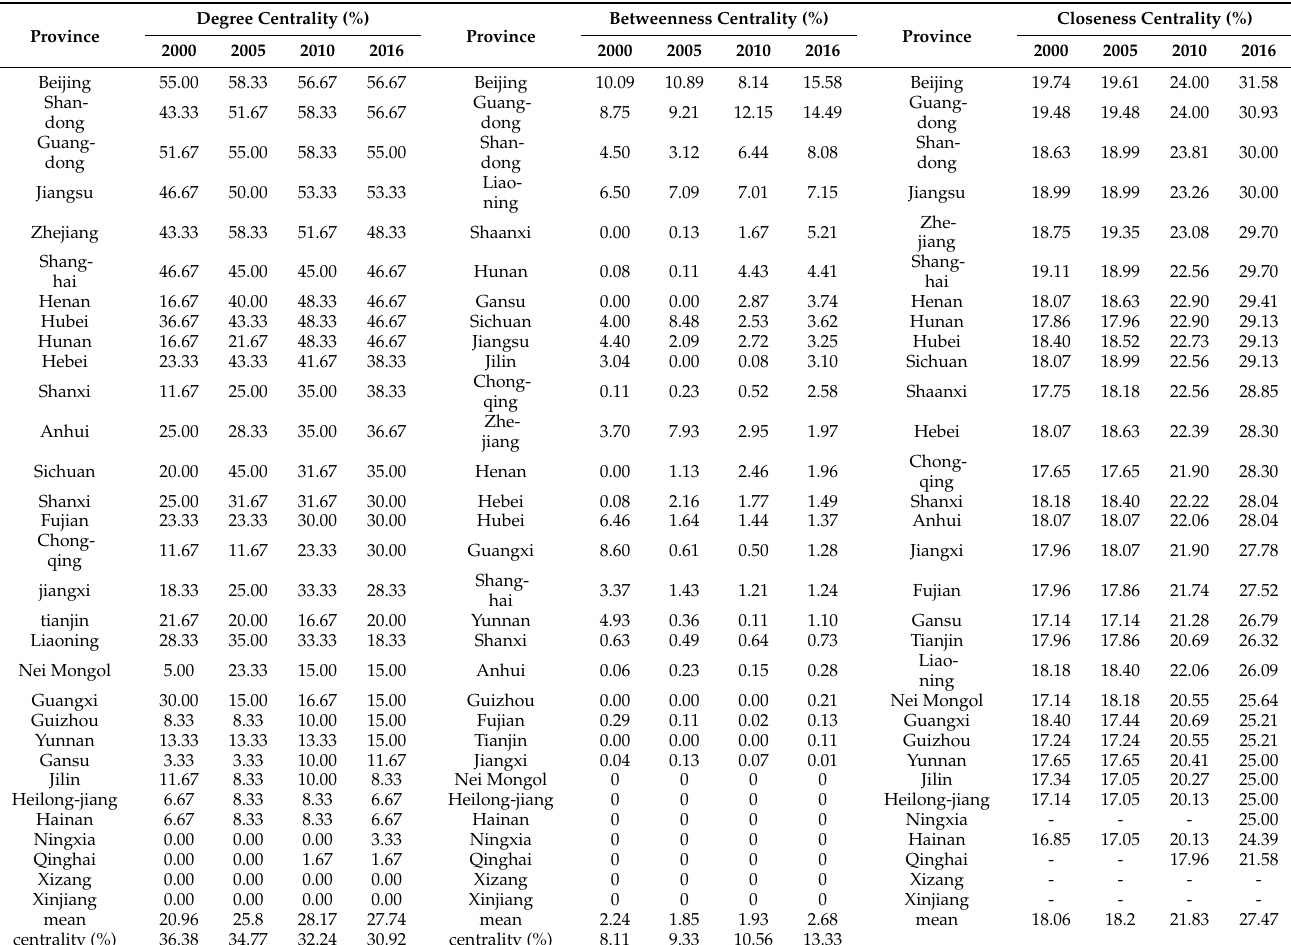
Table 2. Centrality of the tourism investment spatial correlation network in China from 2000 to 2016.